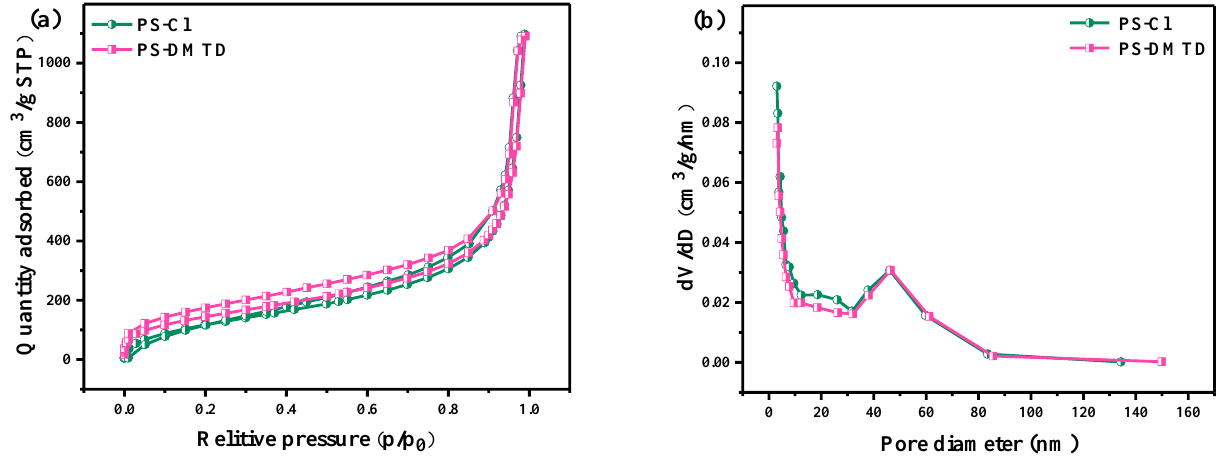
Figure 3. ( a ) N 2 adsorption–desorption isotherms for PS-Cl and PS-DMTD and ( b ) the corresponding pore size distribution (BJH). Table 1. BET data of PS-Cl and PS-DMTD.